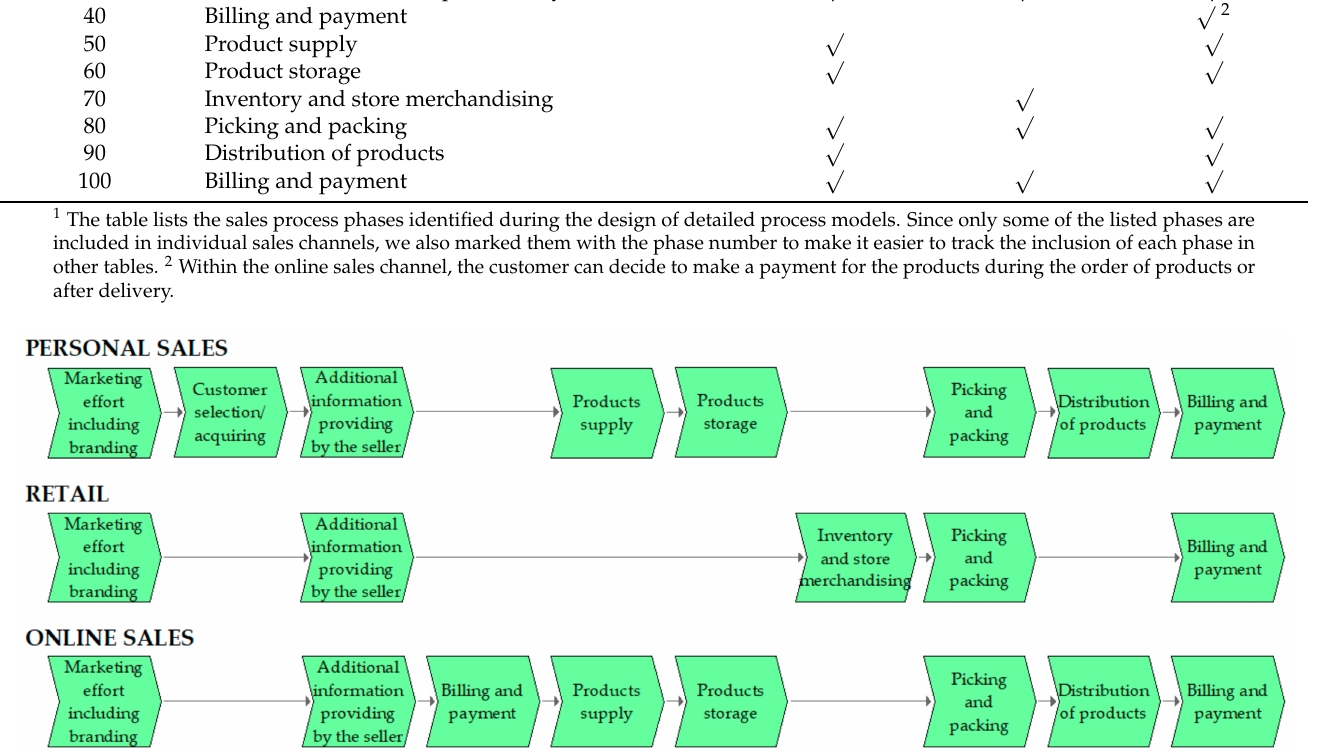
Figure 6. The sequence of sales process phase execution by sales